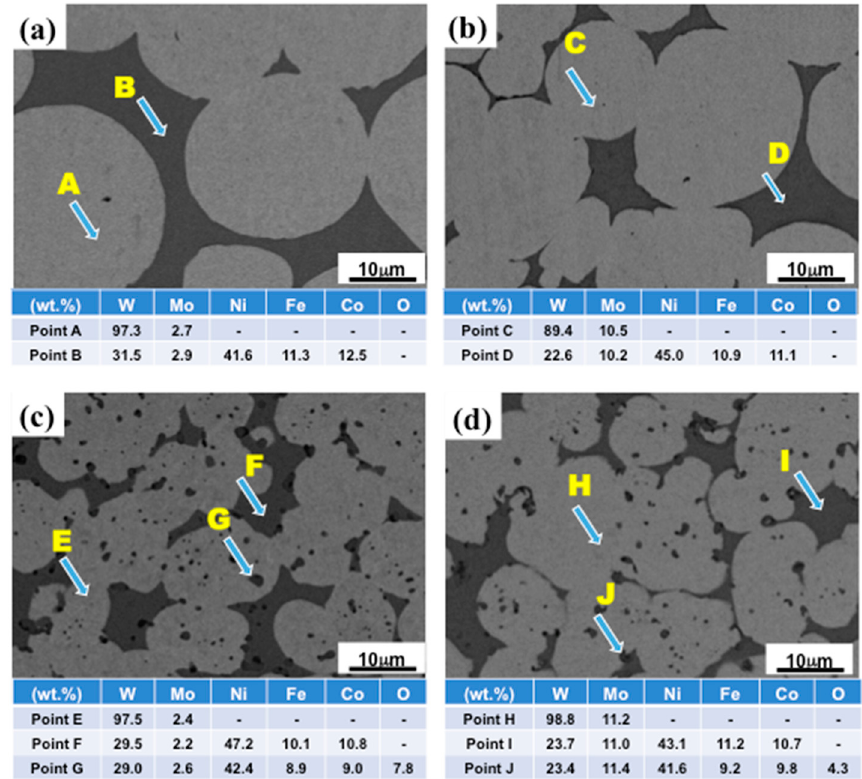
Figure 5. Energy-dispersive X-ray spectroscopy ( EDS) analysis of the sintered ( a ) W3Mo, ( b ) W12Mo, ( c ) W3Mo-YO, and ( d ) W12Mo-YO model alloys milled for 24 h.